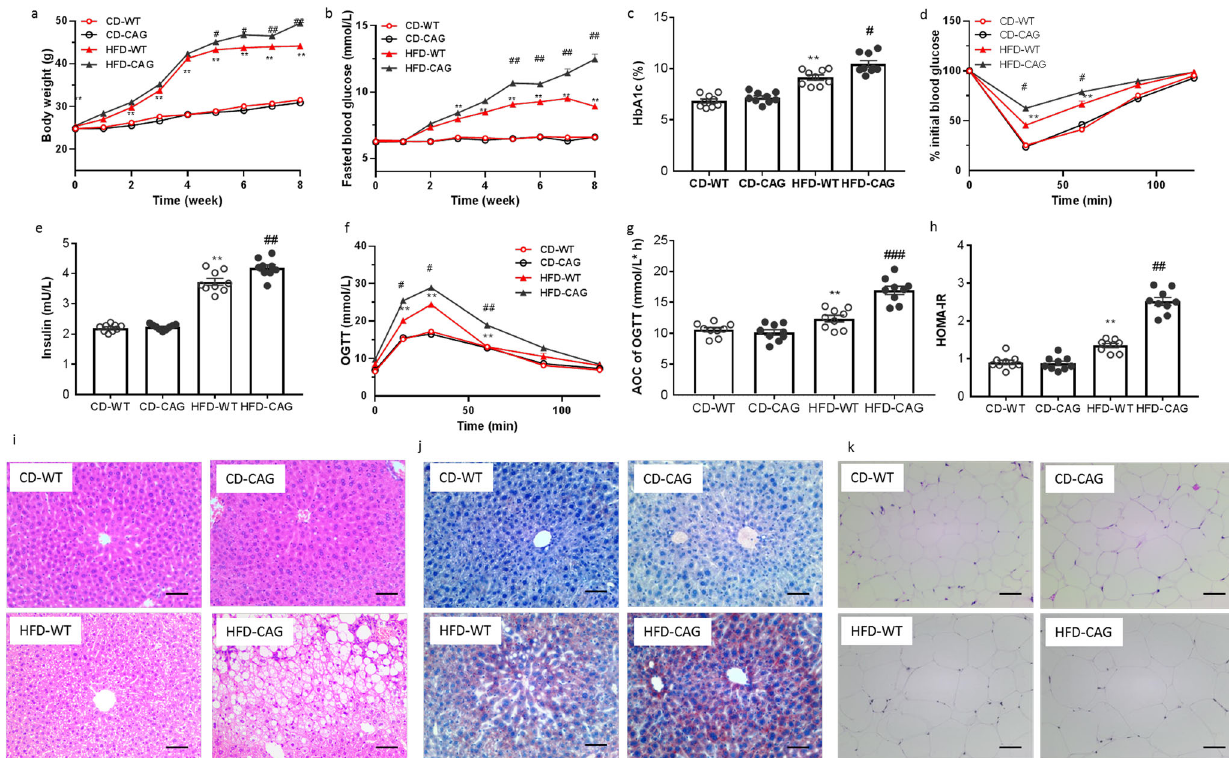
Fig. 5 Feeding with 1,3- β -Glucan isolated from C. albicans (CAG) promoted insulin resistance. In both CD fed and HFD fed mice. a Body weight, b sequential monitoring of blood glucose after 4 h fasting, c HbA1c, d ITT on the 29th day, e plasma insulin, f OGTT and g AOC on the 36th day of treatment in HFD-fed mice, h HOMA-IR, i , j representative images of H & E-stain, oil-red stain of liver tissue, and k representative images of H & E-stain of adipose tissue, Scale bars = 100 μ m ( n = 3 mice per group). Data are presented as the mean ± standard error of the mean (SEM); n = 9 mice per group. Statistical analysis was done using one-way ANOVA followed by the Tukey post hoc test. * P < 0.05; ** P < 0.01 vs CD-WT group, and # P < 0.05; ## P < 0.01 vs HFD-WT